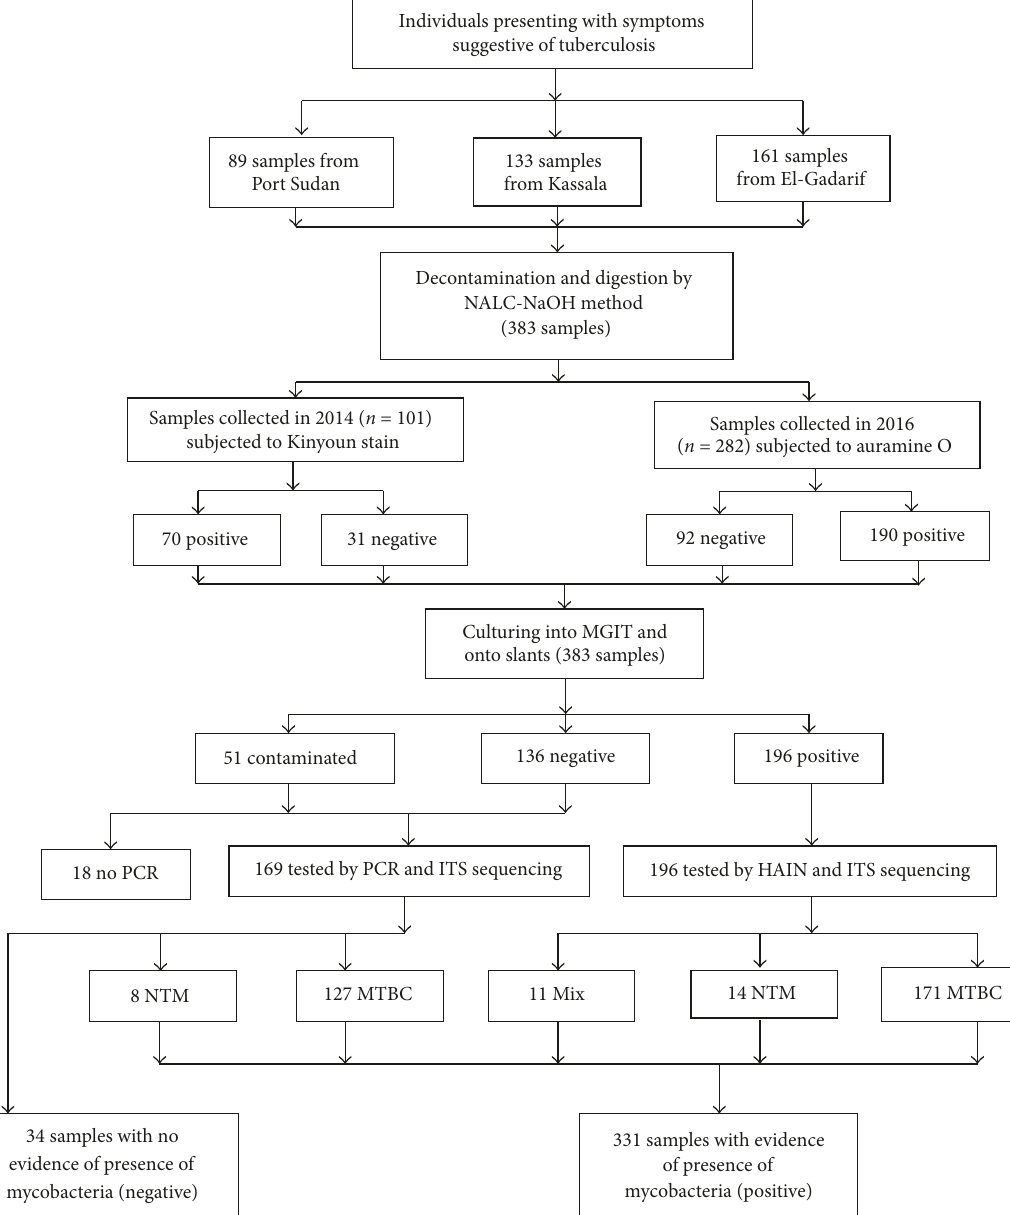
Figure 2: Flowchart of the results. NALC-NaOH: sodium hydroxide/N-acetyl cysteine; MGIT: mycobacteria growth indicator tube; PCR: polymerase chain reaction; HAIN: line probe assay for GenoType CM and GenoType MTBC; MTBC: Mycobacterium tuberculosis complex; NTM: nontuberculous mycobacteria; Mix: two different mycobacteria grown on the same